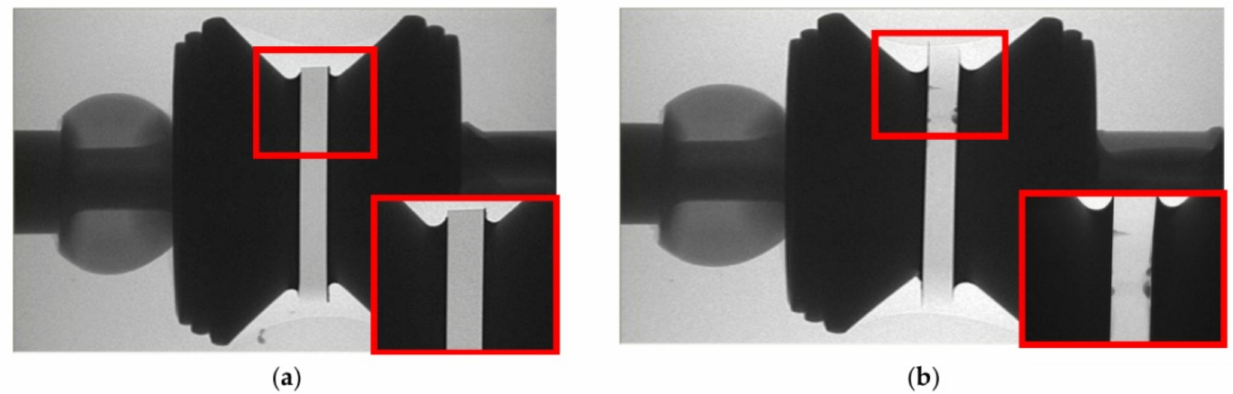
Figure 6. X-ray photos of bypass diode in normal and unhealthy condition ( a ) normal operating bypass diode; ( b ) faulty bypass diode. Reproduced from [38], MDPI: 2018.